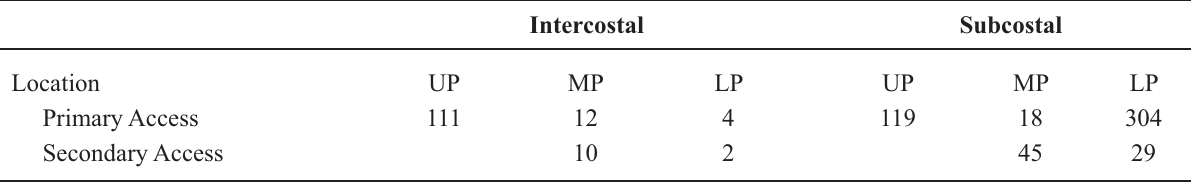
Table 1 – Primary and secondary access for